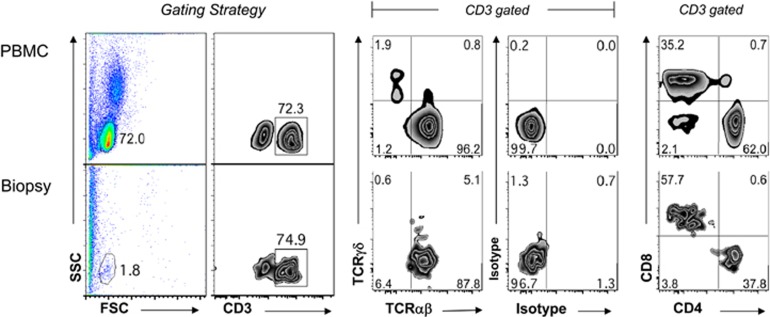
Flow cytometry gating strategy of cells isolated from esophageal biopsies: peripheral blood mononuclear cells were utilized to establish the lymphocyte gate (top panels). Flow cytometry plots representative of peripheral blood mononuclear cells and cells extracted from the biopsies are shown (bottom panels). Cells were identified as lymphocytes based on their forward (FSC) and size scatter (SSC) and analyzed for their expression of TCRαβ, TCRγδ, CD3, CD4 and CD8.